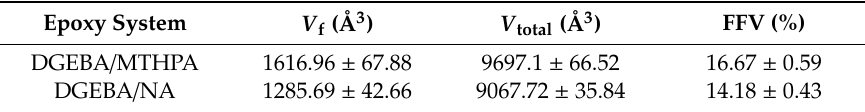
Table 3. Free volume of the epoxy system.